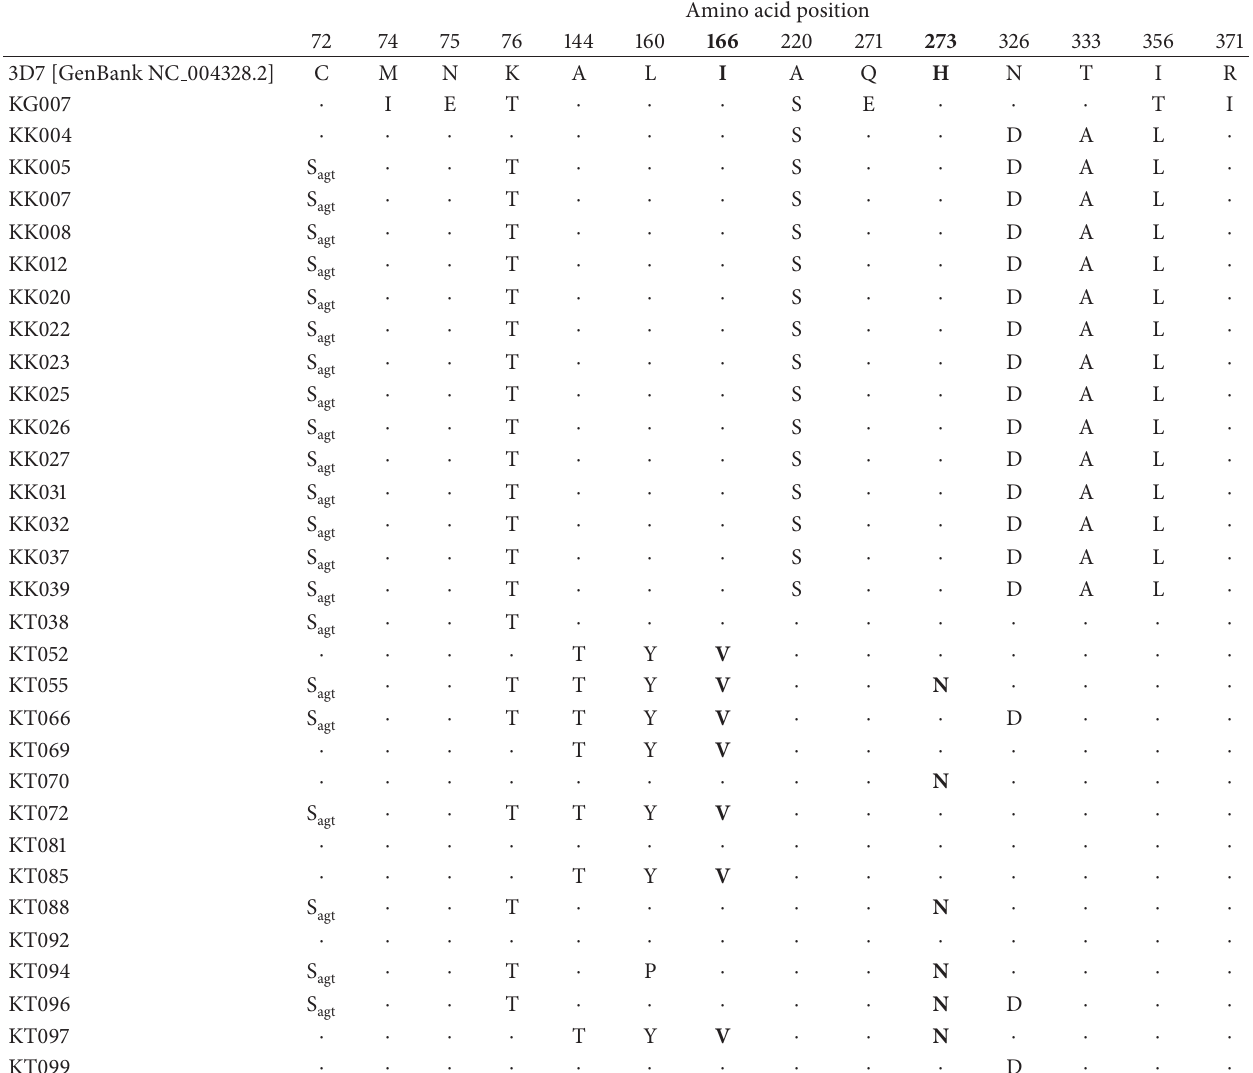
Table 2: Analysis of point mutation in pfcrt among P. falciparum isolates from Sabah.